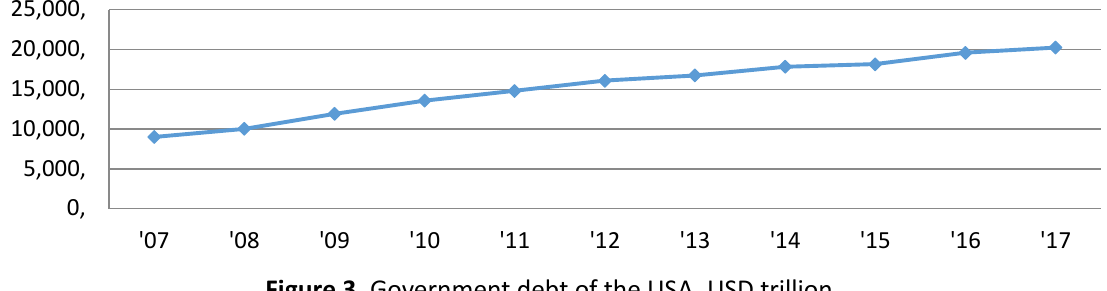
Figure 3. Government debt of the USA, USD trillion